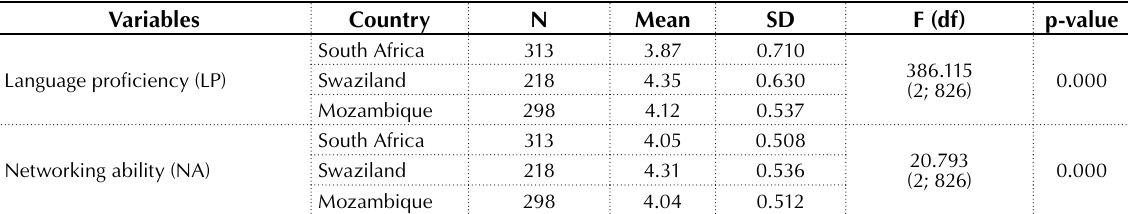
Table 4. Country-specific ANOVA results for the variables of language proficiency (LP) and Networking ability (NA)